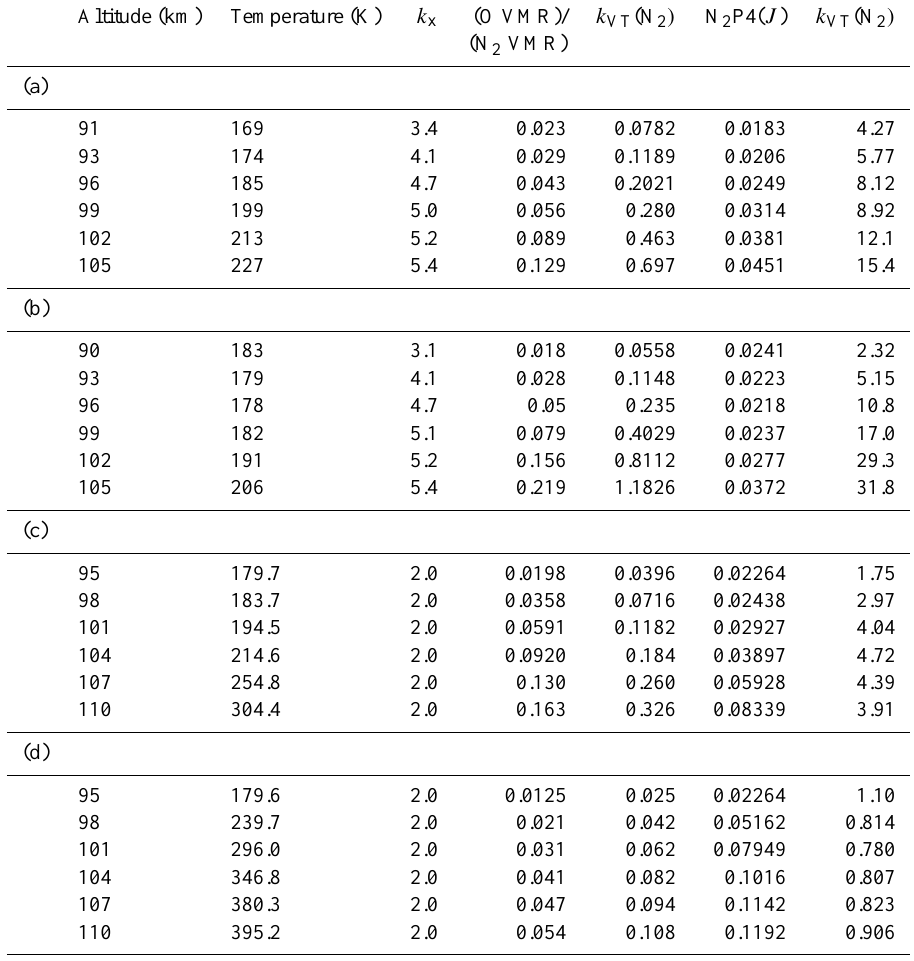
Table 1. Rate coefficient for deactivation of CO 2 ( v 2 ) by thermal N 2 , k VT (N 2 ), required if collisions with thermal N are the missing source of 15µm emission as function of altitude for different model atmospheres. (a) MLW atmosphere (A. G. Feofilov, 19 October 2014), (b) MLS atmosphere (A. G. Feofilov, 19 October 2014), (c) polar summer SABER model atmosphere (López-Puertas, 11 November 2014), and (d) polar winter SABER model atmosphere (López-Puertas, 11 November